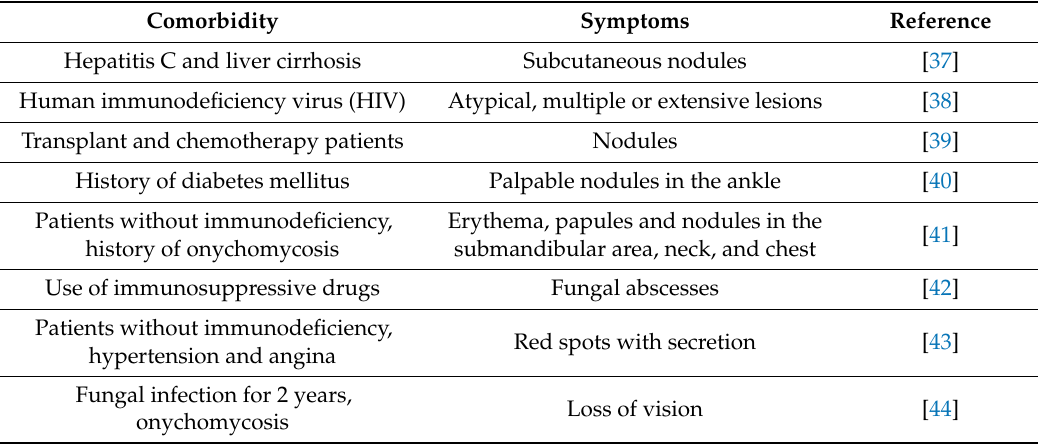
Table 2. Case reports of deep infections caused by